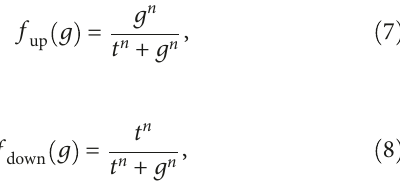
Table 1: Transformation from a fl ower individual x work piece π i